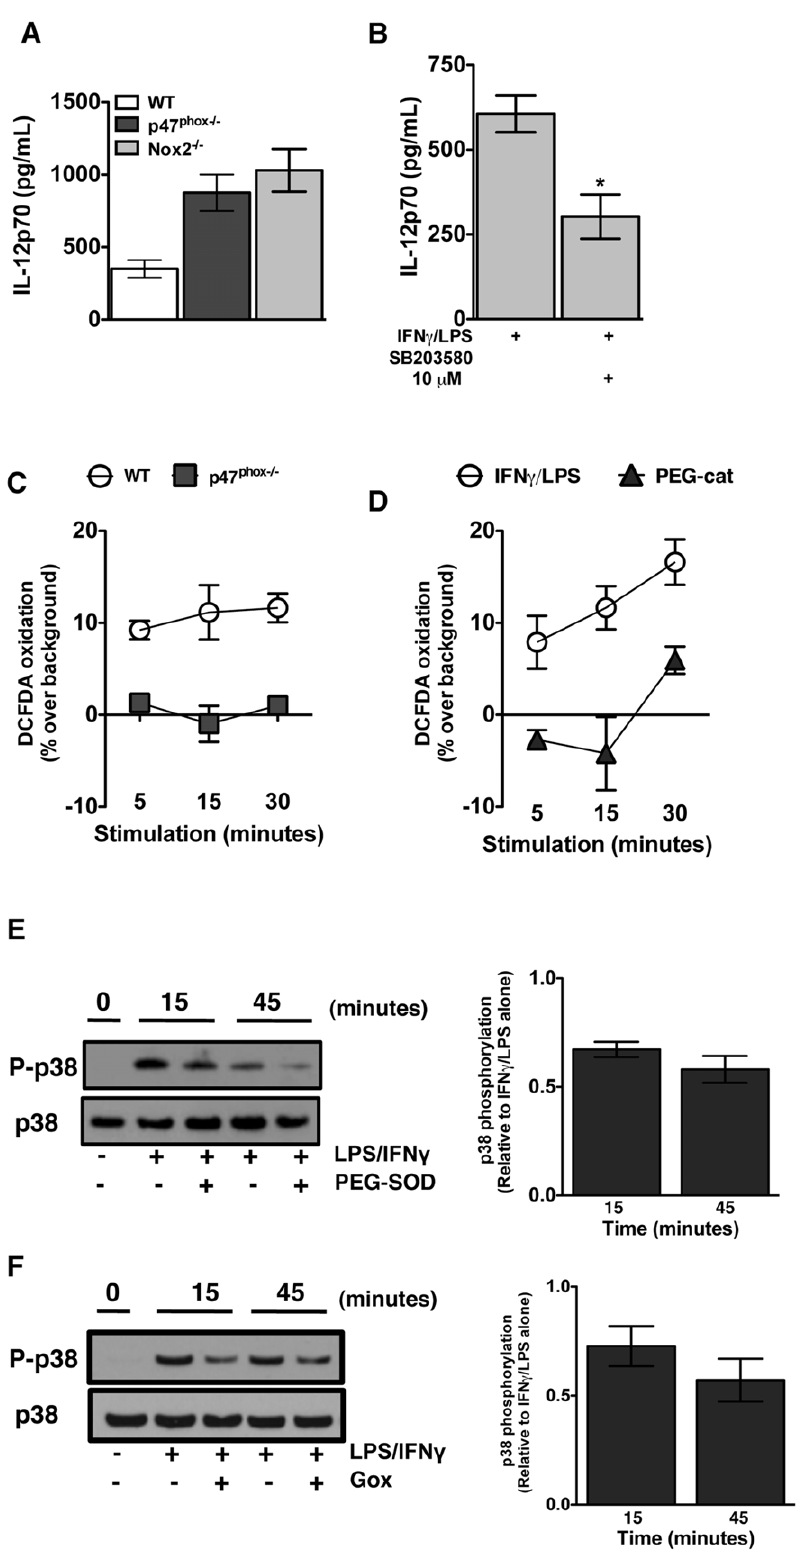
Figure 4. Nox2-derived H 2 O 2 is a critical secondary messenger for IFN c /LPS induced DC IL-12p70 expression. (A) Enhanced secretion of IL-12p70 detected in IFN c /LPS stimulated DC supernatants from p47 phox and Nox2 2 / 2 mice. (B) Enhanced secretion of IL-12p70 detected in IFN c / LPS stimulated DC supernatants from Nox2 2 / 2 mice treated, or not, with SB203580. The data are the mean ( 6 SEM) percentage for 5 individual experiments with 3 of each genotype/experiment, with 0.5–1 6 10 6 DC, respectively. Immature DC were stimulated with IFN c /LPS for 0, 5, 15, and 30 minutes. All samples were pulsed with 2 m M DCFDA for the final 15 minutes of incubation. DCFDA dye oxidation in WT and p47 phox 2 / 2 DC